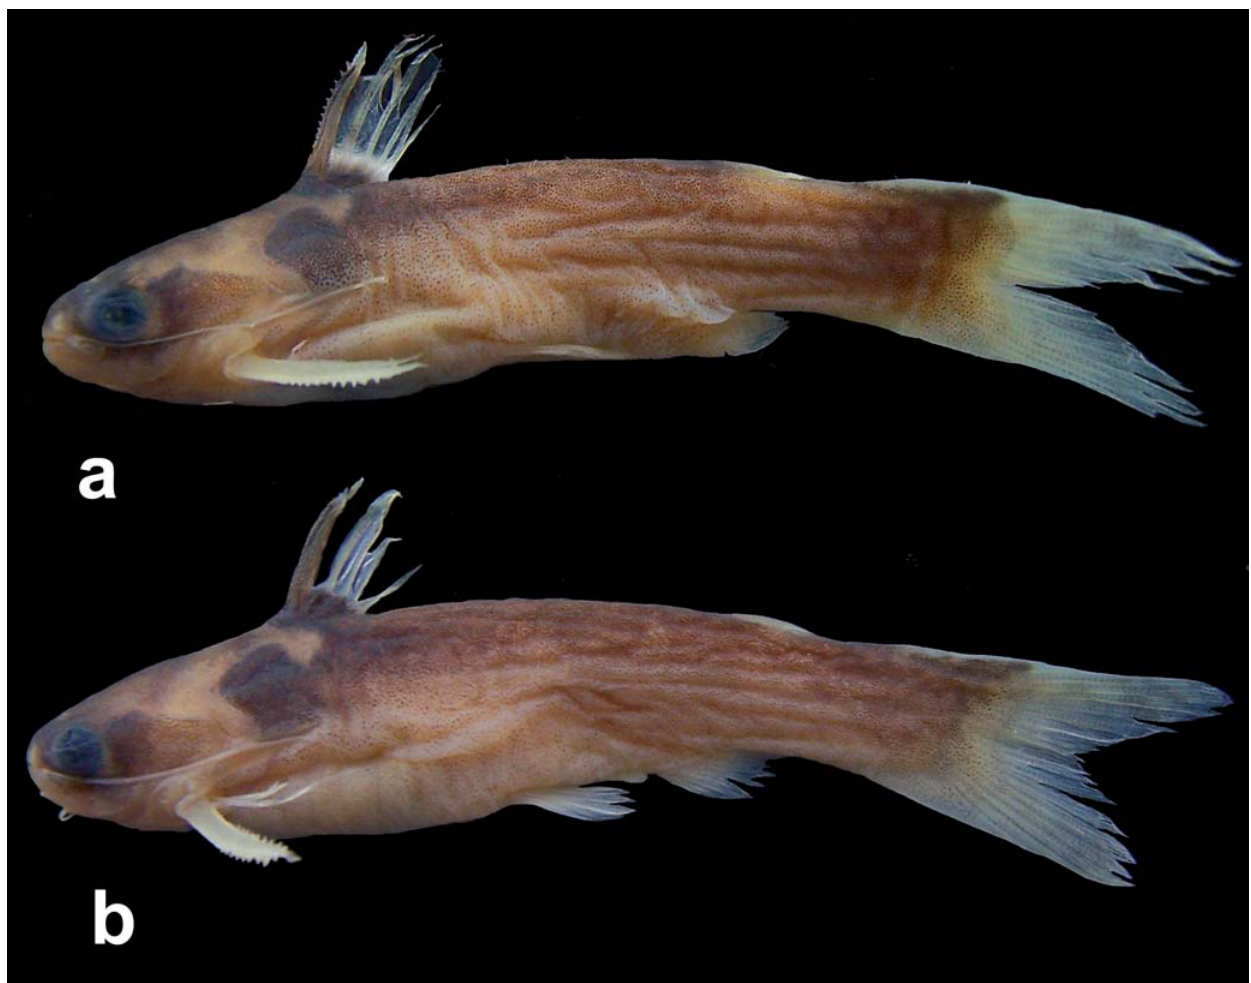
Fig. 30. Tatia meesi . (a) holotype, INHS 99772, male, 44.3 mm SL. (b) paratype, INHS 49549 , female, 46.6 mm SL, Essequibo river,